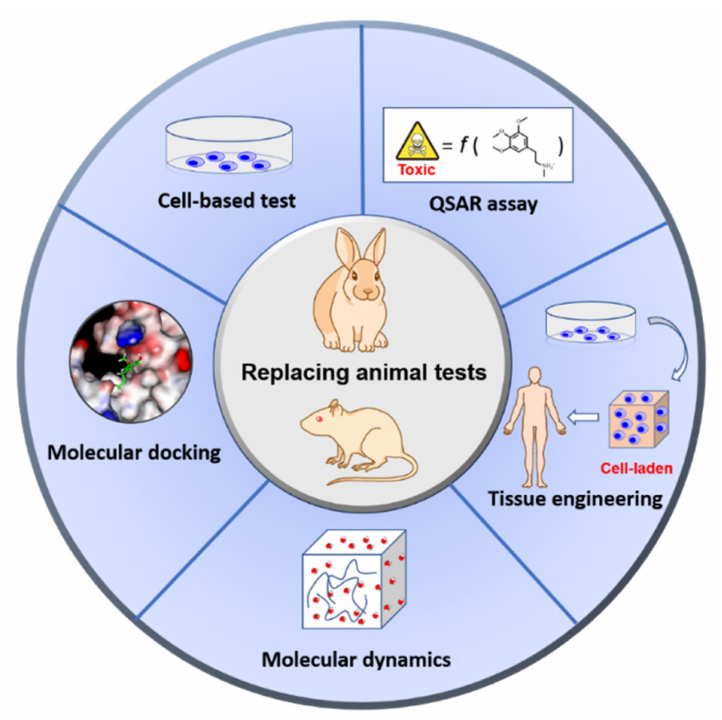
Figure 1. An overview of the current alternatives to the use of animals, including cell-based tests, tissue engineering, and computer-based techniques for nanotoxicity assessment. Cell-based tests and tissue engineering are in vitro approaches. In silico techniques include the application of prediction methods in nanotoxicity studies, such as molecular docking; quantitative structure– activity relationship (QSAR) assays; molecular dynamics simulations. Both in vitro and in silico approaches can be used to overcome ethical problems in medical research and